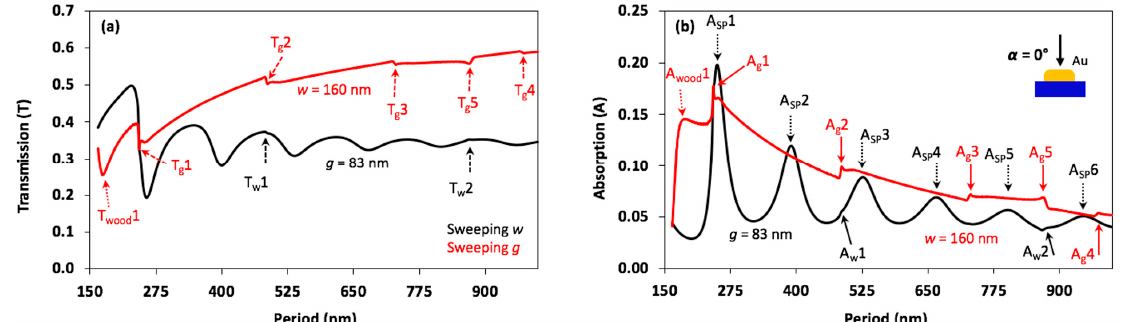
Figure 3. Transmission (T) and absorption (A) plots as a function of structure period at normal incidence. The red curves show the result of varying the period as a function of slit width ( g ) with w = 160 nm, and the black curves show results for varying the period as a function of wire width ( w ) with g = 83 nm. In ( a ), the transmission spectrum is plotted, with Rayleigh’s anomaly positions emphasized via dashed black and red arrows. These anomalies are located at P = 243, 487, 731, 868, and 961 nm, labeled as T g 1/A g 1, T g 2/A g 2, T g 3/A g 3, T g 4/A g 4, and T g 5/A g 5, respectively. T w 1/A w 1 and T w 2/A w 2 can be clearly seen due to the effect of surface plasmon polaritons. In ( b ), the absorption spectrum, Raleigh-Wood anomalies and surface plasmon polaritons are shown. Solid red and black arrows correspond to the positions of dashed red and black arrows in ( a ). Black dotted arrows in ( b )